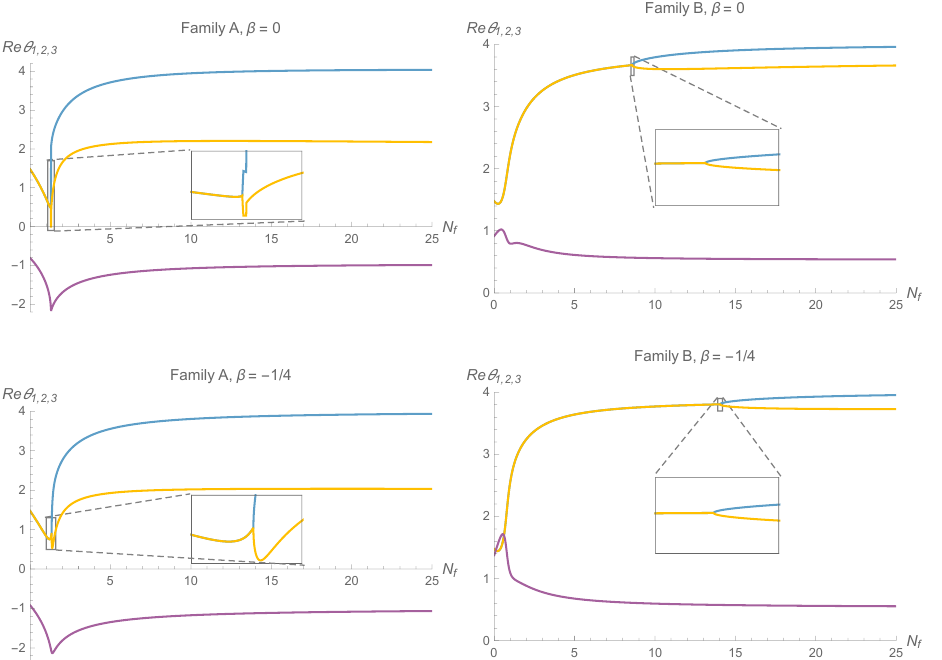
Figure 5. The critical exponents associated with the NGFPs comprising Family A and Family B for both values of β . The families come with two and three relevant directions, respectively. This is independent of the choice of coarse-graining operator and N f . Furthermore, the critical exponents ≈ 1.34 and N B ≈ 14 in the case that β = − 1/4, whereas they become real at become real at N A f f ≈ 1.29 and N B ≈ 8.6 in the case that β = N A f f